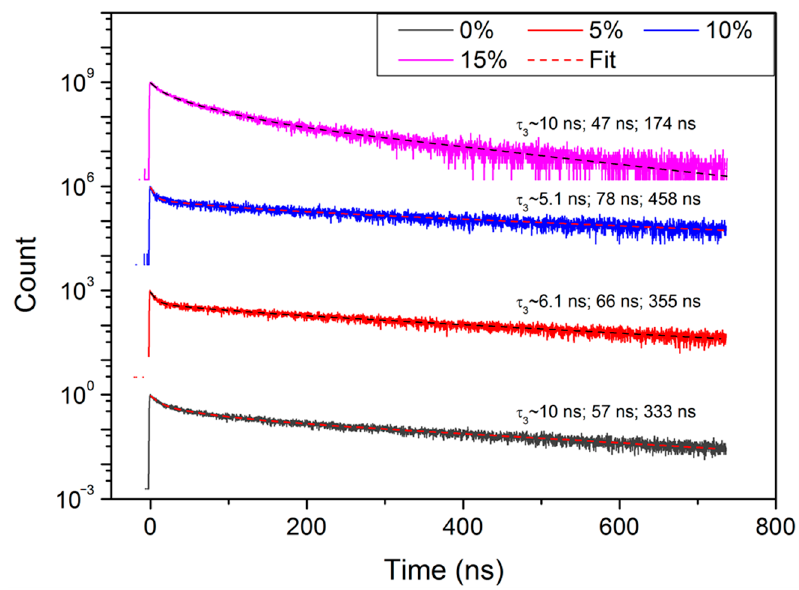
Figure 8. Photoluminescence decay transients of the perovskite layers with a different cesium con- centration.